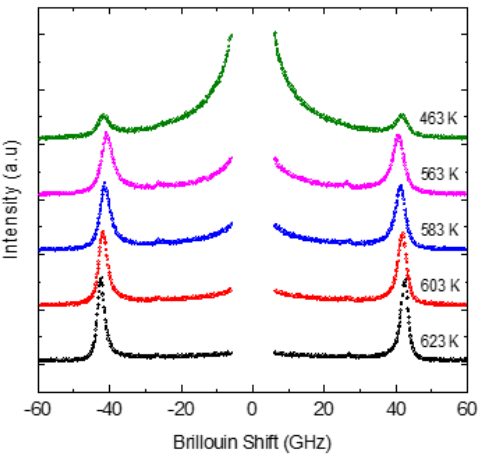
Figure 12. Brillouin spectra of 0.65PIN-0.35PT at various temperatures.